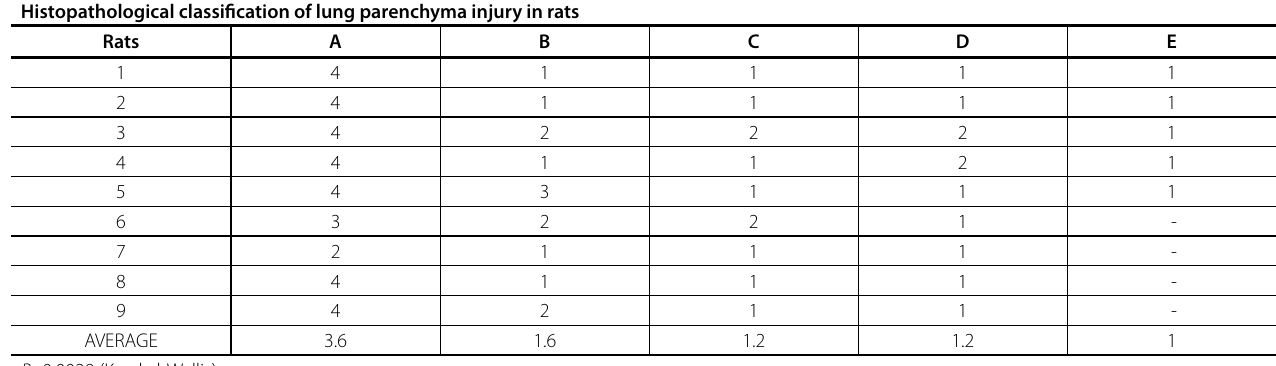
Table 1. Results of statistic analysis of tissue injuries. Histopathological classification of lung parenchyma injury in rats